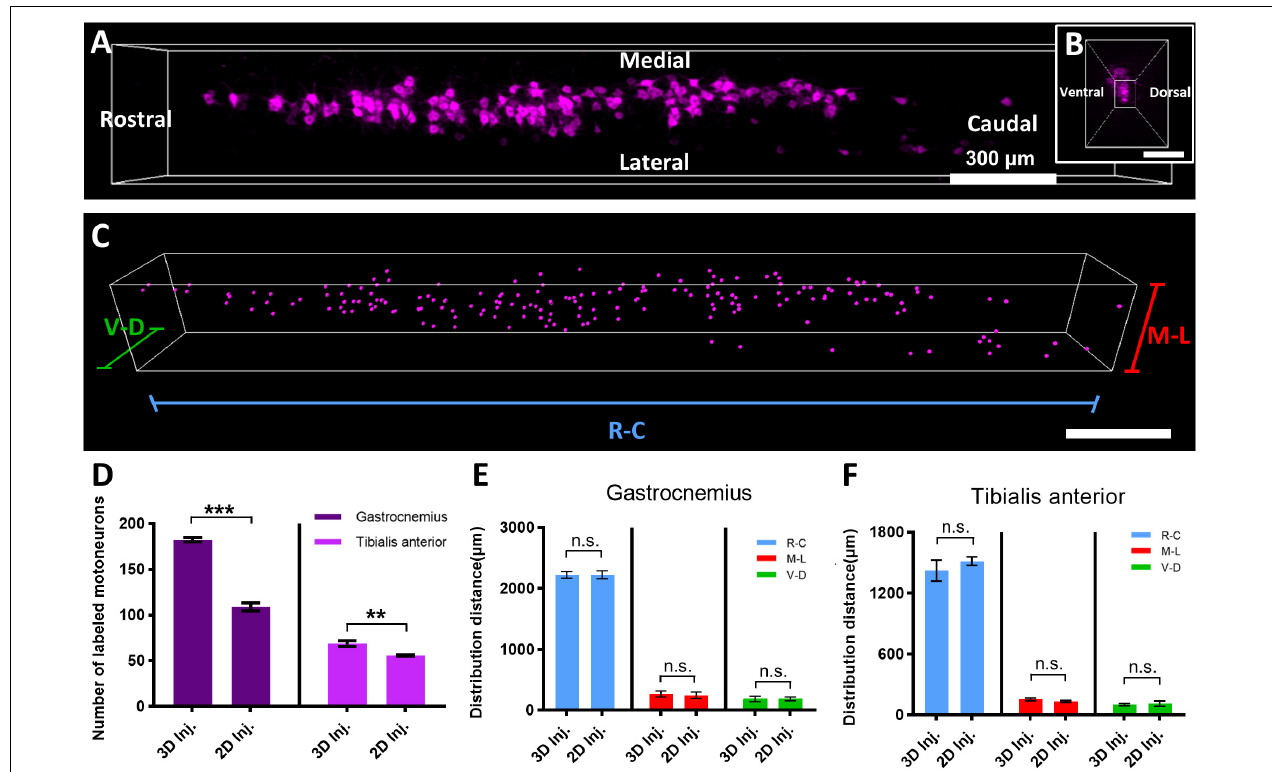
FIGURE 5 | Quantitative comparison of the distribution characteristics of labeled motor neurons by the two injection strategies. (A) 3D reconstruction of labeled motor neurons in the spinal cord. (B) The cross-sectional view corresponding to panel (A) . (C) The quantification of distribution characteristics of motor neurons via the Spot and Vantage modules in Imaris. (D) Comparison of the neuron number of the gastrocnemius and tibialis anterior labeled by the two injection strategies ( n = 4 for the gastrocnemius and tibialis anterior). (E,F) Comparison of the distribution range of motor neuron pools corresponding to the gastrocnemius and tibialis anterior labeled by the two injection strategies ( n = 4 for the gastrocnemius and tibialis anterior). Data are presented as mean ± SEM. Statistical significance (n.s. represents no significance, ** p < 0.01, *** p < 0.001) was assessed by independent-sample t -test.